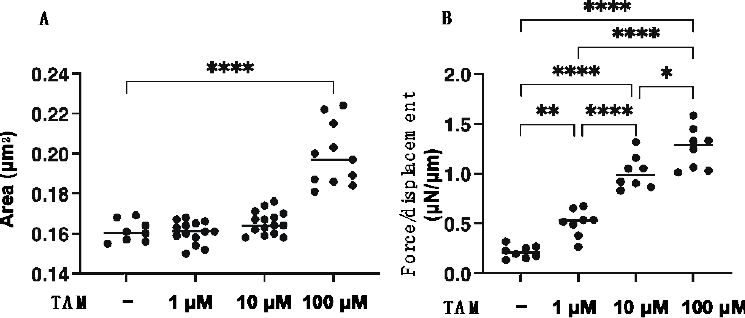
Figure 4. Effects of different concentrations of tamsulosin (TAM) on the physical properties, mean sizes and physical stiffness of the 3D ARPE 19 spheroids. The 3D ARPE 19 spheroids at Day 5 were prepared in the absence or presence of 1 μM, 10 μM or 100 μM tamsulosin (TAM). In the panel ( A ), their mean sizes and physical stiffness obtained by measuring the phase contrast images were plotted. In the panel ( B ), their physical stiffness was evaluated by the compressing them into their semidiameter (μm) during 20 sec using a micro-squeezer, and the requiring force/displacement (μN/μm) values were plotted. All experiments were performed in duplicate using fresh preparations ( n = 12 and 15-20 for size and stiffness measurement, respectively). Data are presented as the arithmetic mean ± standard error of the mean (SEM). * p < 0.05, ** p < 0.01, **** p < 0.001 (ANOVA followed by a Tukey’s multiple comparison test).